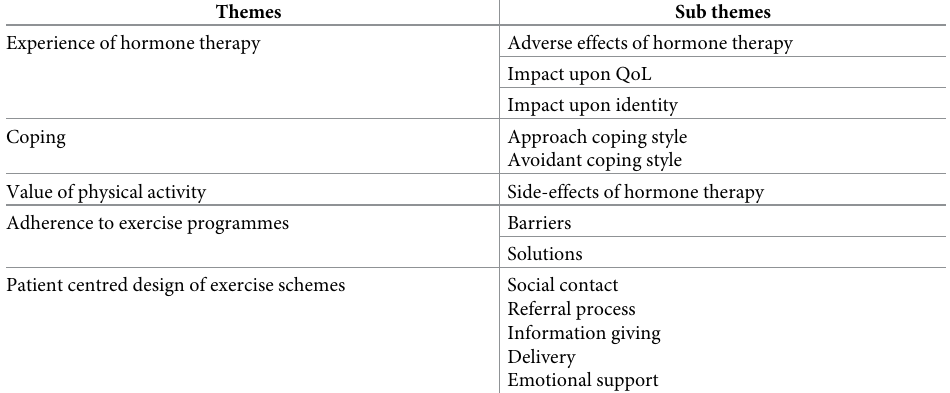
Table 5. All focus groups themes and